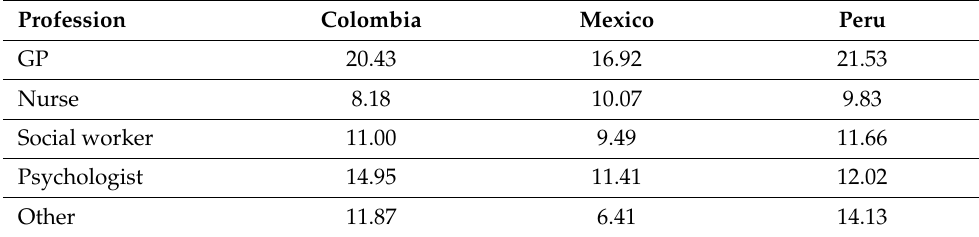
Table A4. Average hourly salary of different health care professionals involved in the SCALA project (Int$).